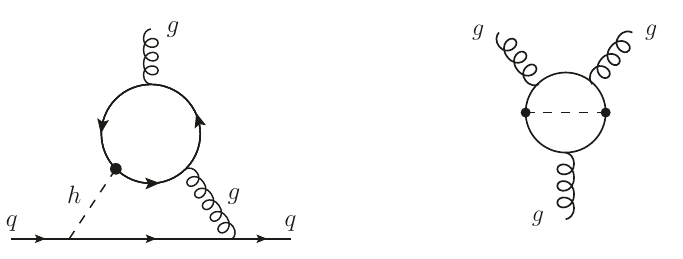
Figure 4 . Two-loop diagrams giving rise to a cromoelectic dipole moment for the light quarks (left) and to the Weinberg operator